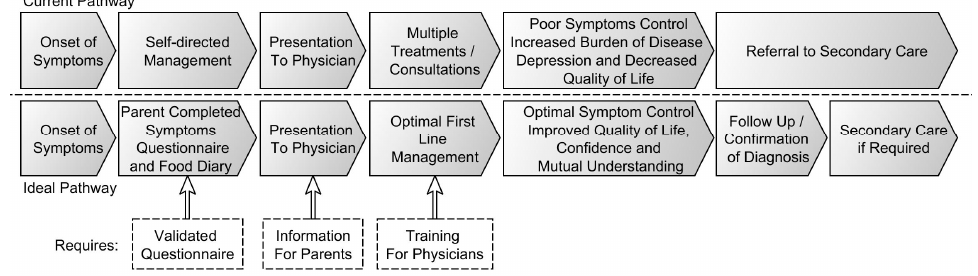
Figure 3. Discord in